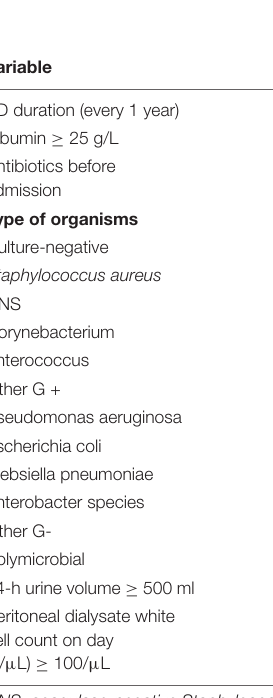
TABLE 2 | Univariate and multivariable logistic regression of cure in the training dataset. Univariate